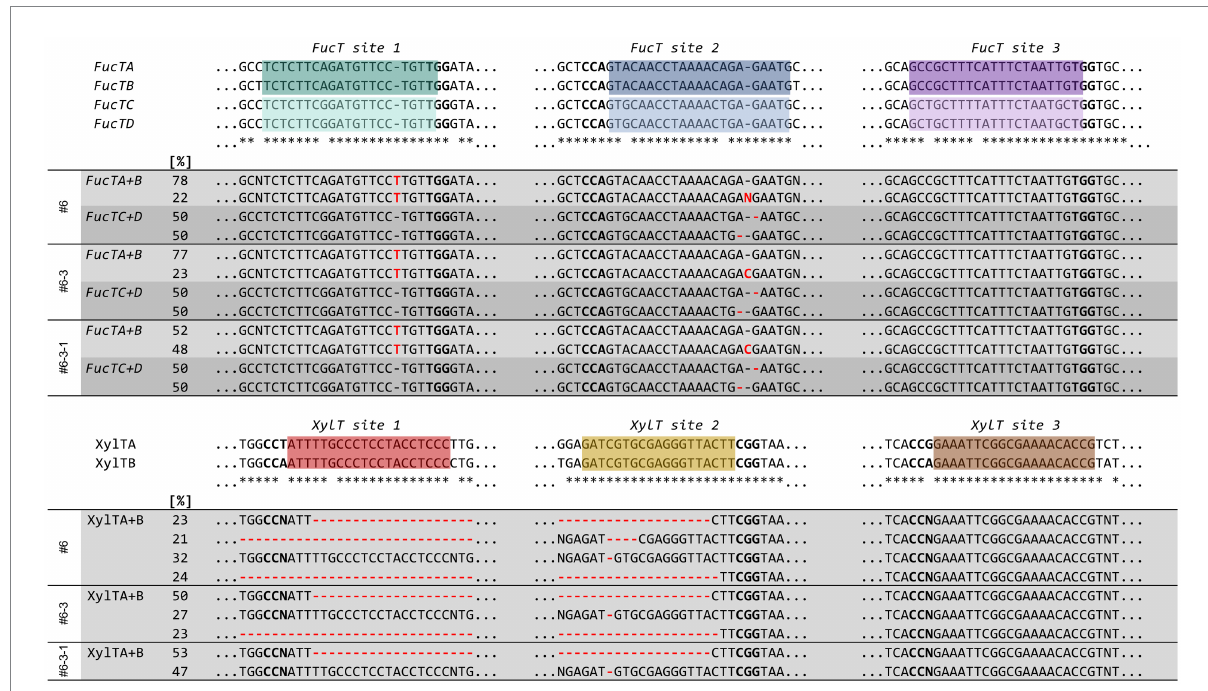
FIGURE 3 Genetic characterization of transgenic NtFX-KO line. Sequences of the regions targeted by pFGC-LFX in the FucTA-D and XylTA-B genes of NtFX- KO lines #6 (T 0 generation), #6-3 (T 1 generation), and #6-3-1 (T 2 generation) were identified by Sanger sequencing, and the PCR amplicons analyzed using Synthego ICE. The corresponding wild-type sequences are shown above, the sgRNA target sequences are indicated by colored boxes, and the PAM sequences shown in